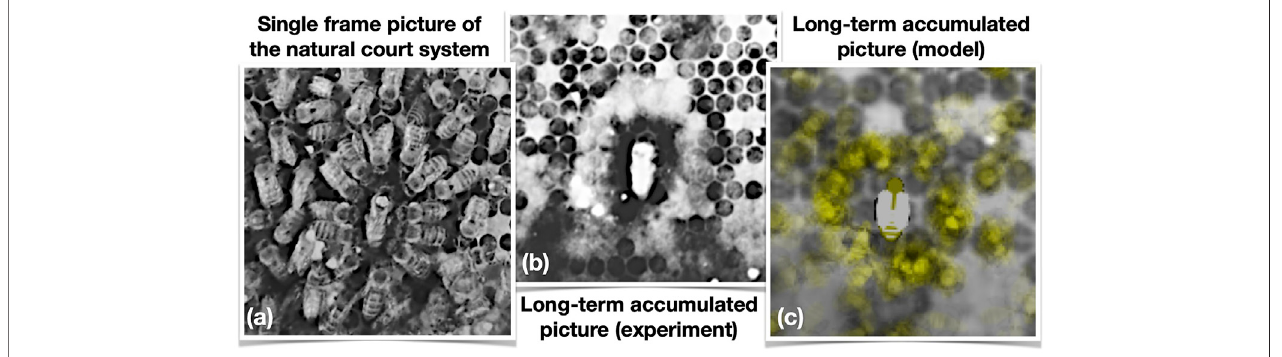
FIGURE 8 | A queen with her courtyard. (A) Photo shot in IR light, single frame from a courtyard event. (B) Median of 154 photos across the duration of the same event,histogram-equalized. (C) Accumulatedpicture ofasimulationrunofourmodel inasimilar courtyardevent. Originalextracted backgroundofcombwasprojected intothesimulationbackground,workerbeesleftasemi-transparentyellowishbodyimprintevery30 s,formingahalo-likestructurearoundthequeen,similartoempirical fi ndings shown in (B)